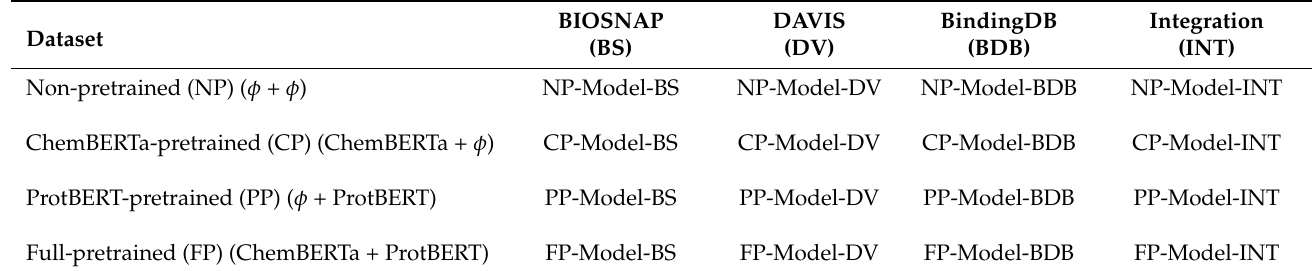
Table 3. Model utilities by the configurations and the training datasets